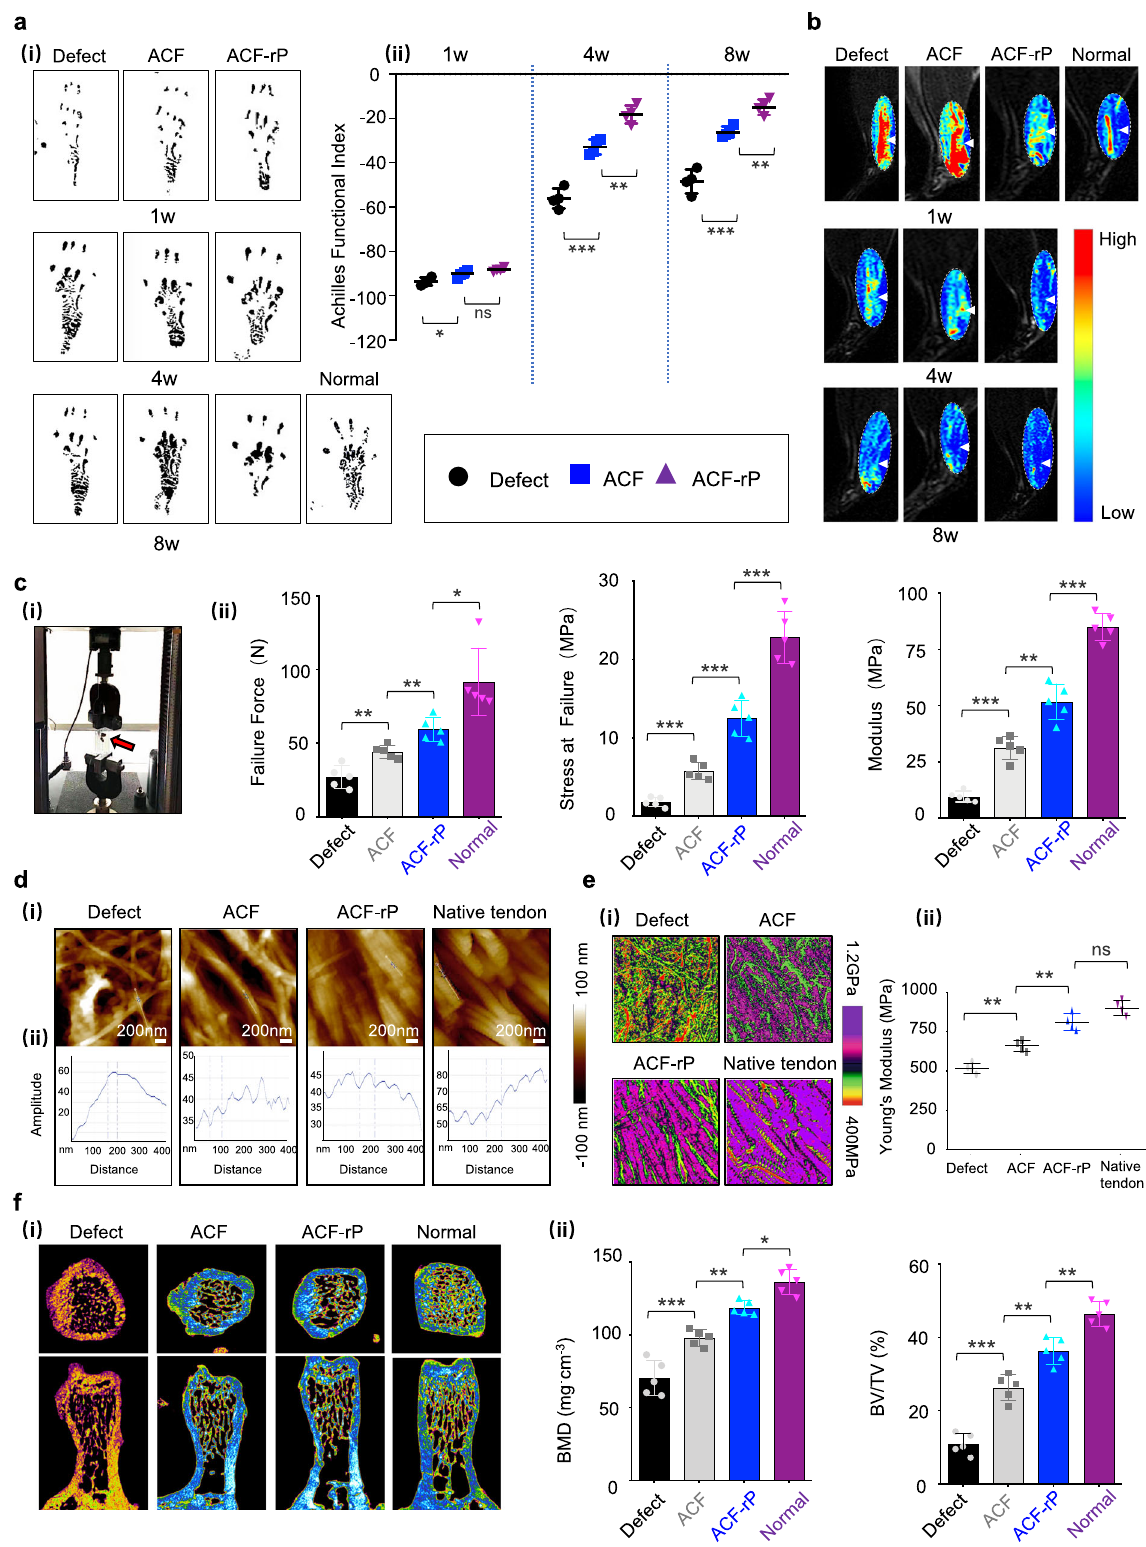
leading to tendon regeneration. By mimicking the tendon fi bril micro/nanopattern, ACF provided an optimal microenvironment for TSPC growth and differentiation. The ACF-rP-regenerated tendons showed near-restoration of native-like mechanical properties, collagen micro/nanostructure and orientation, and locomotion functions (Fig. 8). Further studies would be needed